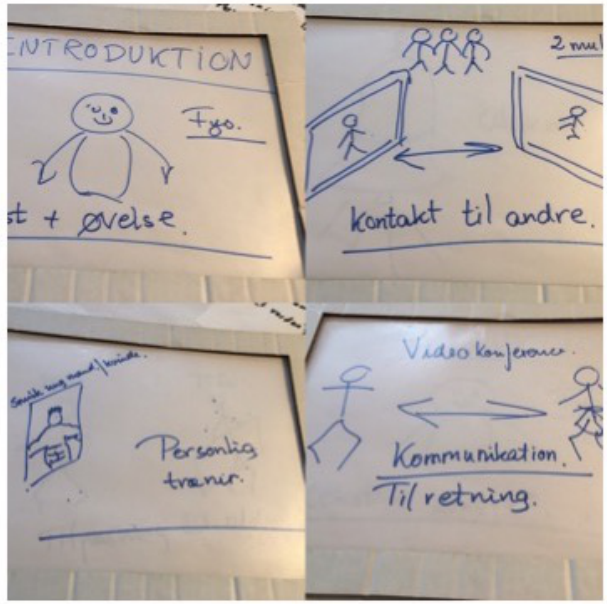
Figure 3. The different features reflecting the participants’ideas about